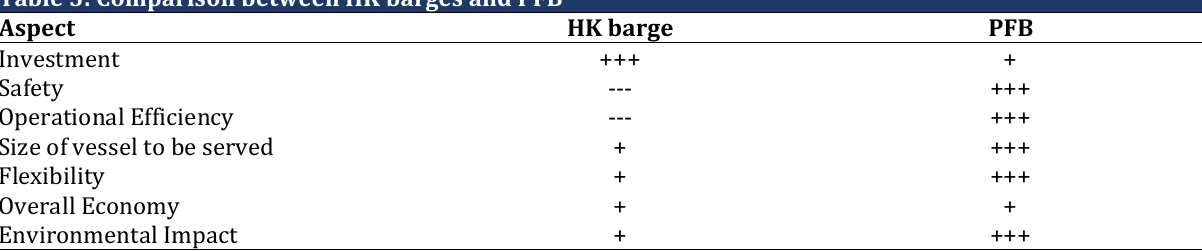
Table 3: Comparison between HK barges and